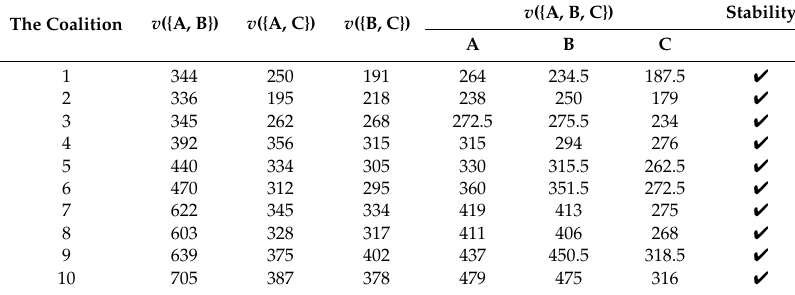
Table 8. The stability of the allocation